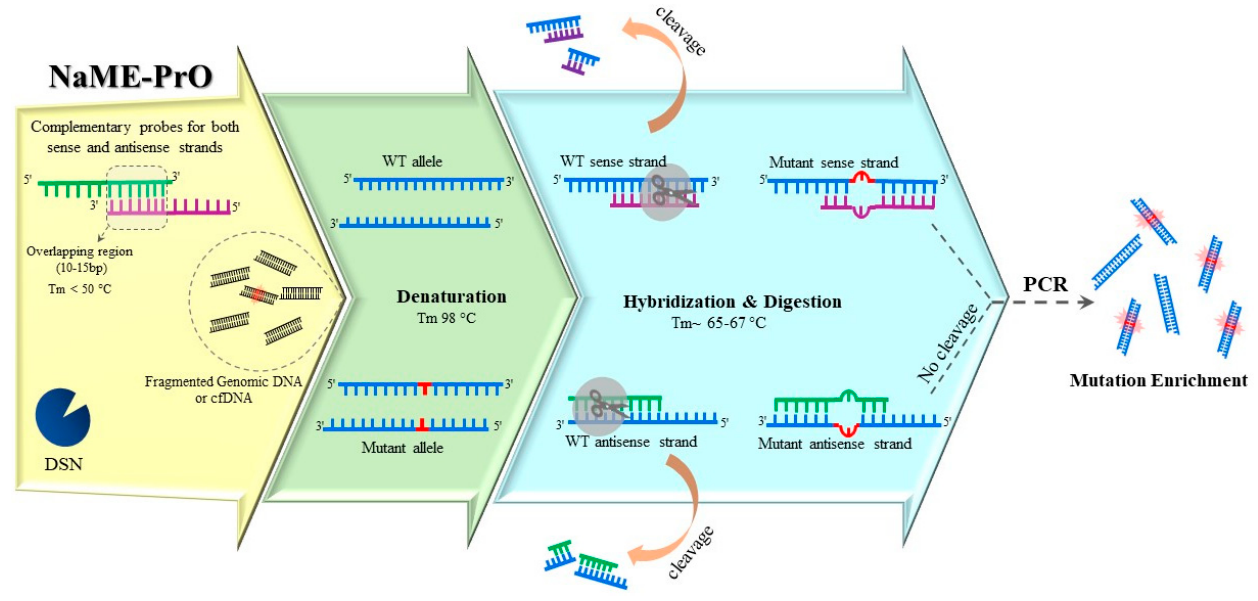
Figure 4. Nuclease-assisted minor-allele enrichment using probe-overlap (NaME-PrO) is applied directly to unamplified genomic DNA, thus reducing the influence of polymerase misincorporations. Using duplex-specific nuclease (DSN) along with overlapping WT-specific probes results in digesting WT alleles preferentially. Following DNA denaturation, the temperature is lowered up to 65 °C, allowing the probe hybridization and catalytic activity of DSN. Hybrids with mismatches due to any mutation within the overlap region of sense and antisense probes escape DSN digestion. The resulting DNA is PCR-amplified, resulting in mutation enriched products.